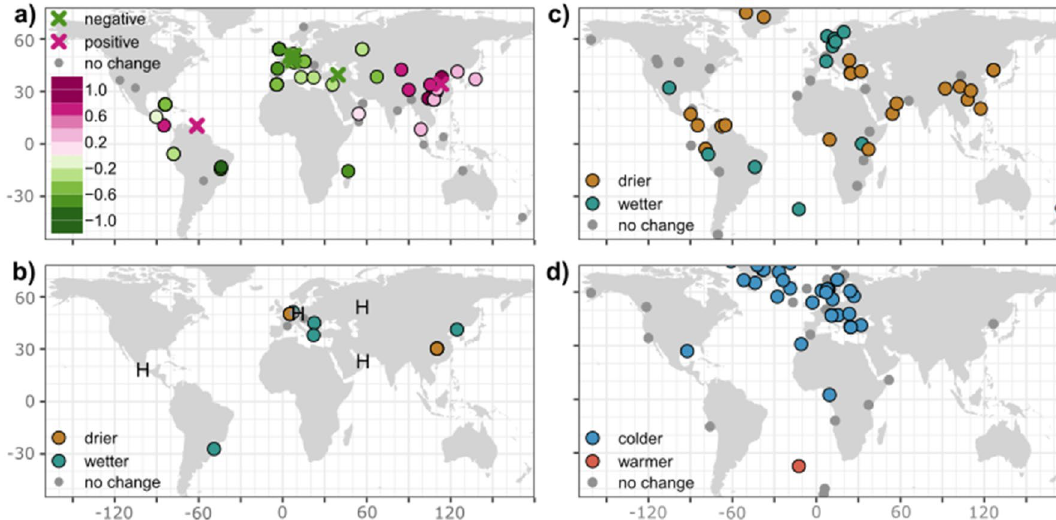
Figure 4. (a) Oxygen isotope anomalies for the 8.2 ka event, registered by speleothem records. The 8.2 ka anomalies determined by breakpoint analysis are shown by filled circles. They are calculated as the mean δ 18 O value between the start and end of the event and given relative to a base period mean δ 18 O, defined as 7.8 ka